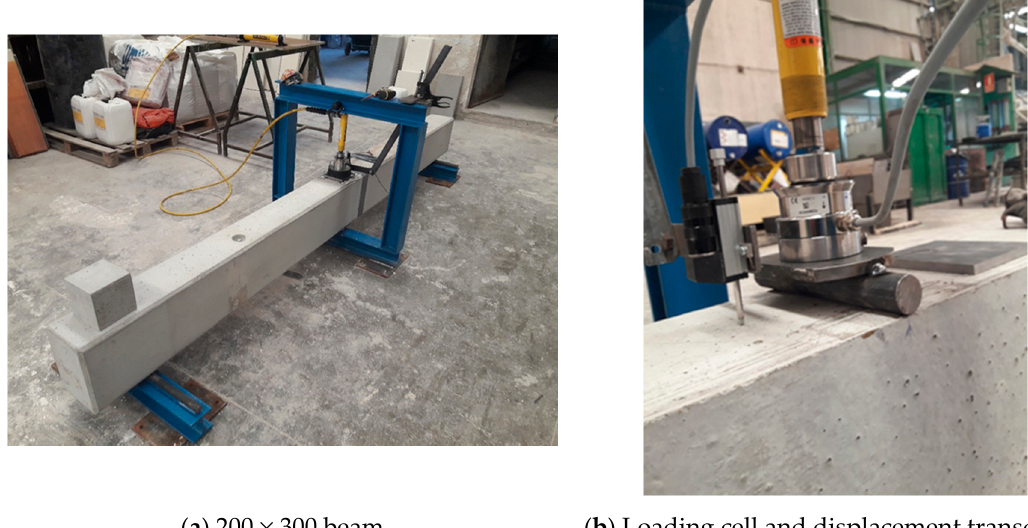
Figure 7. Loading cell and displacement transducer on the 200 × 300 mm beam.